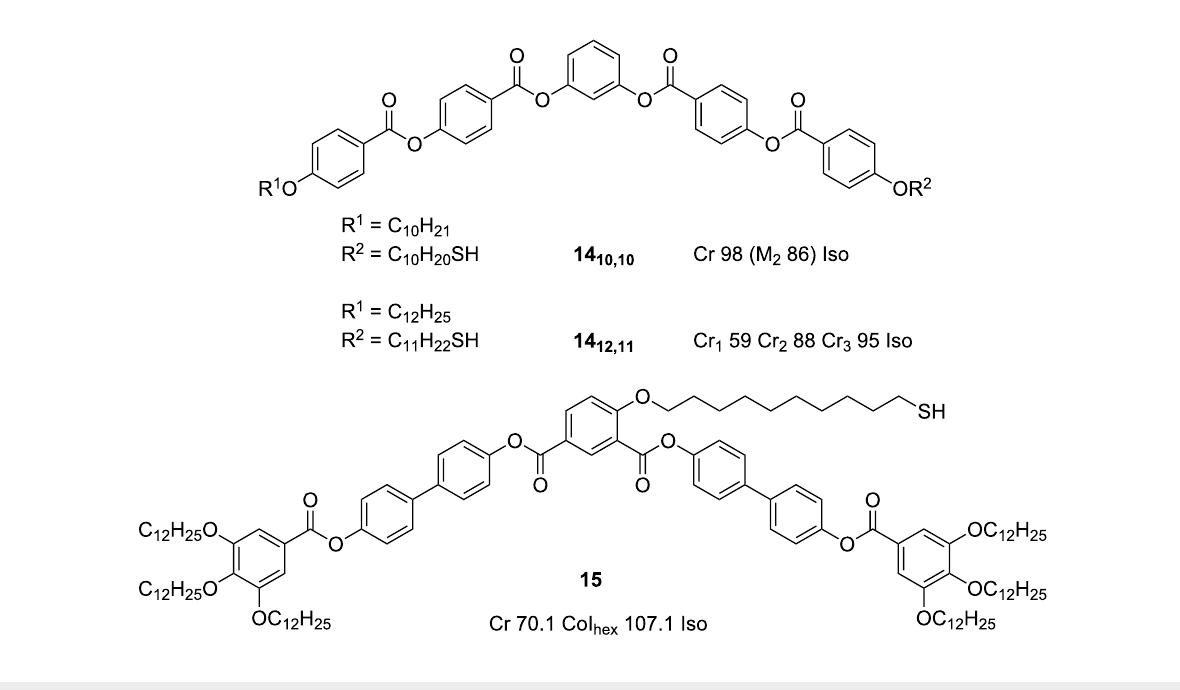
Figure 18: Chemical structures and mesogenic properties of bent-core proto-mesogenic ligands used to coat NPs.